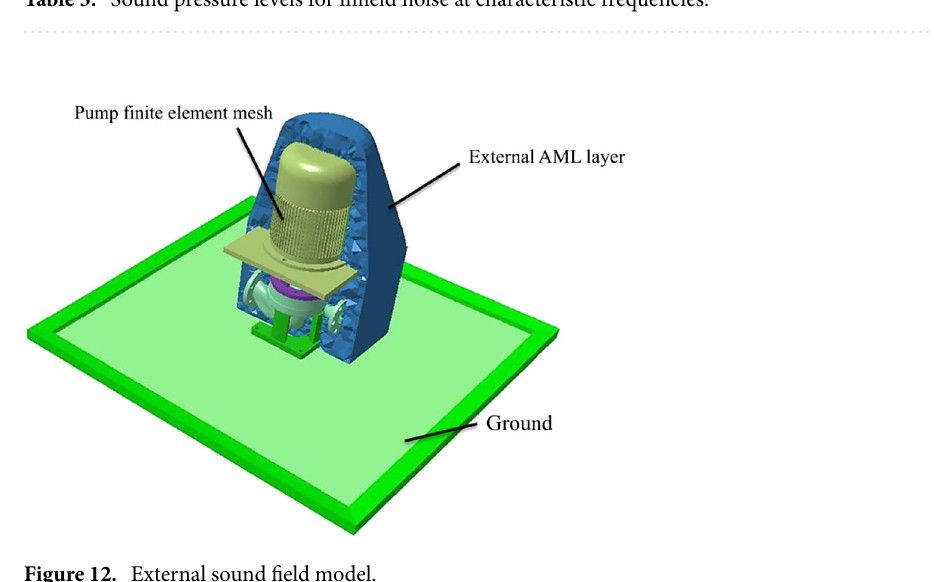
Table 3. Sound pressure levels for infield noise at characteristic frequencies.